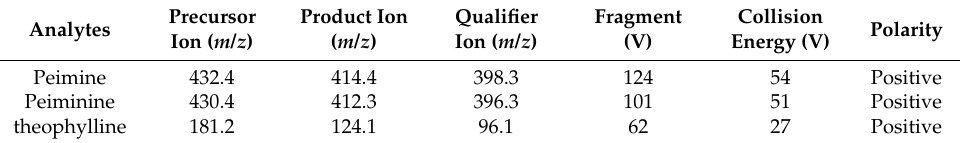
Table 1. Mass spectrometric parameters of peimine, peiminine, and theophylline in MRM